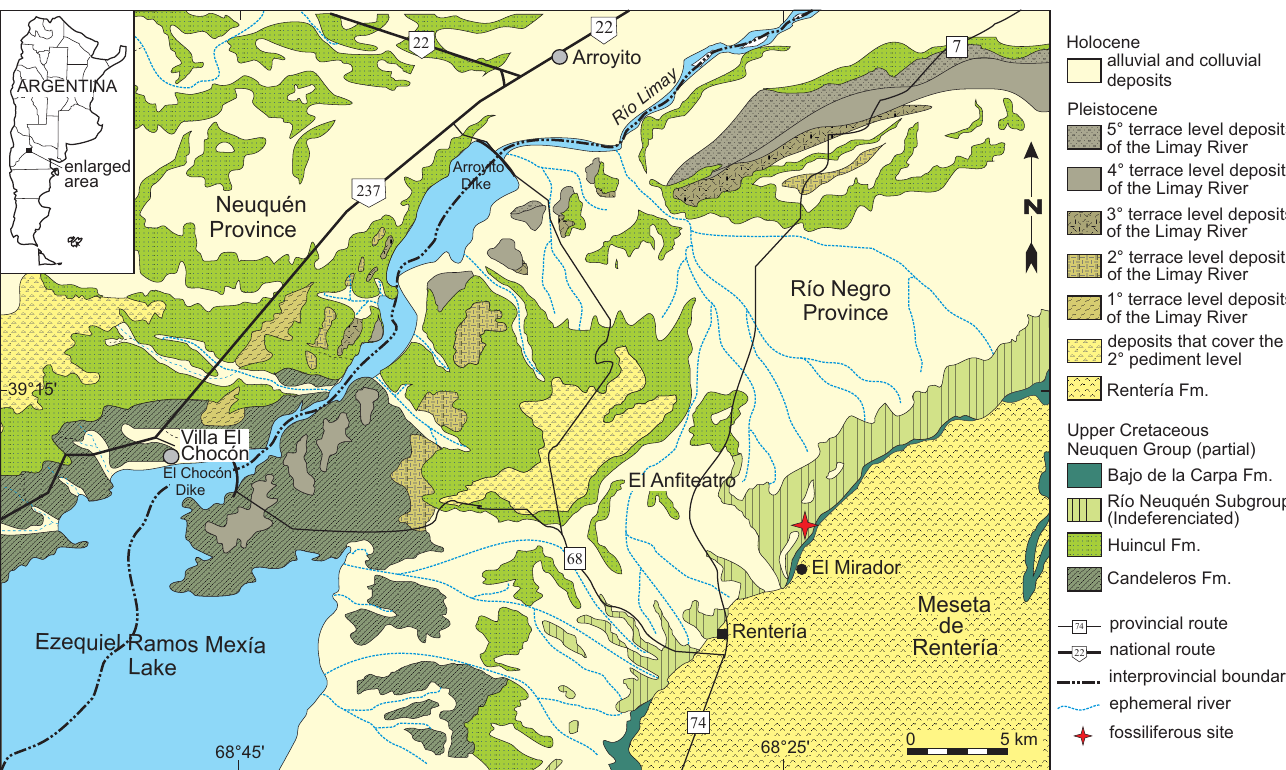
Fig. 1. Geologic map of the “El Anfiteatro” area. Modified from Salgado et al.